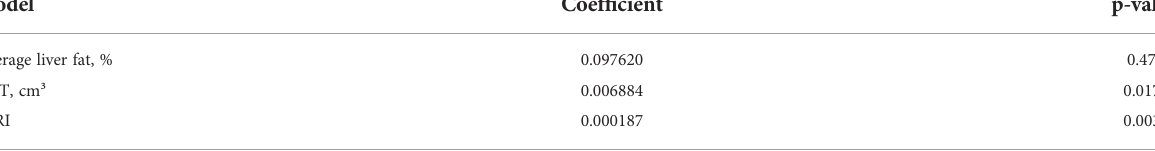
TABLE 4 Multivariate regression analysi with standardized coef fi cients: determinant of hyperglucagonemia in NAFLD (n = 66) matched for BMI-SDS (Model R² = 0.509).